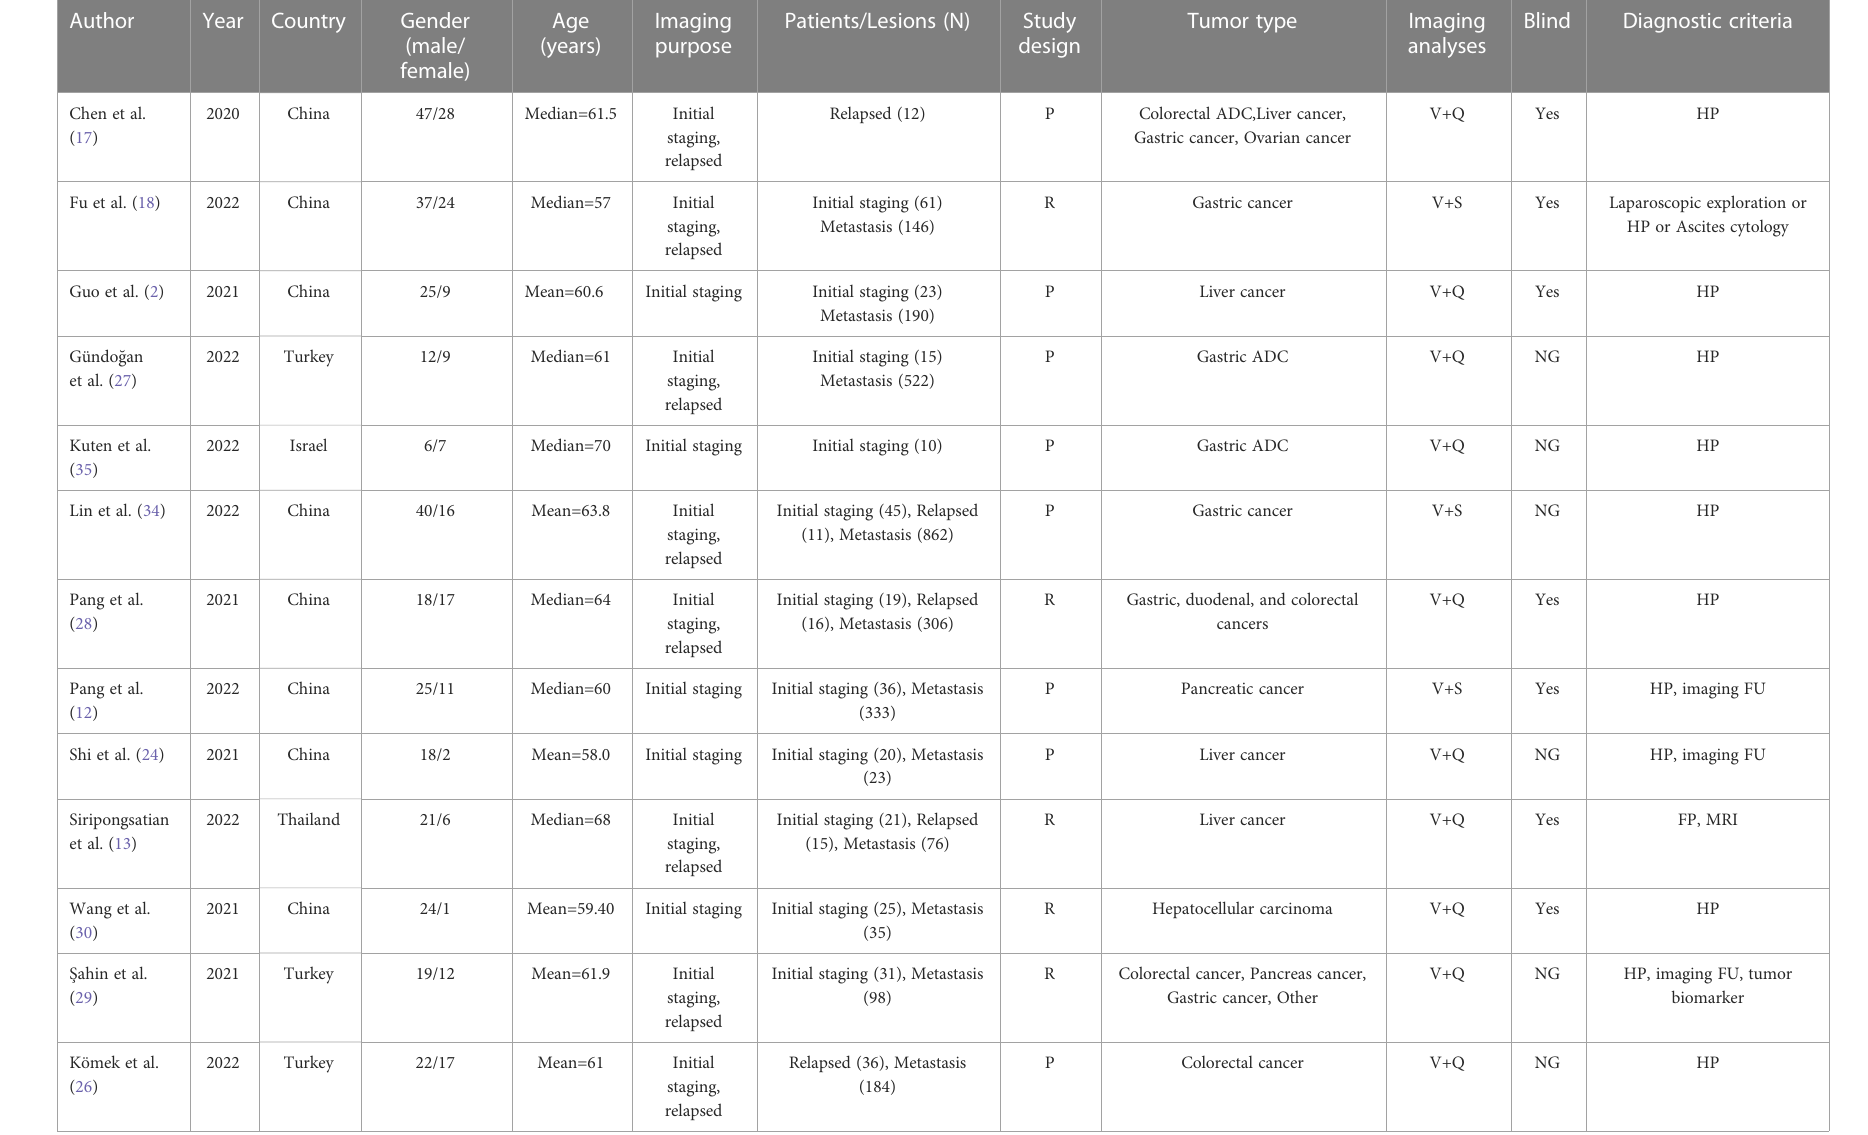
TABLE 1 Basic study and patient